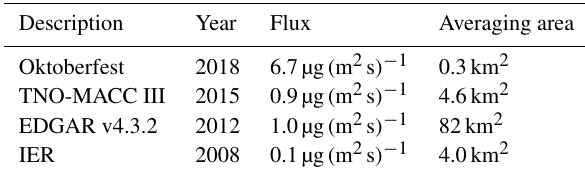
Table 2. Comparison of the Oktoberfest emission flux to state-of- the-art emission inventory fluxes for the same